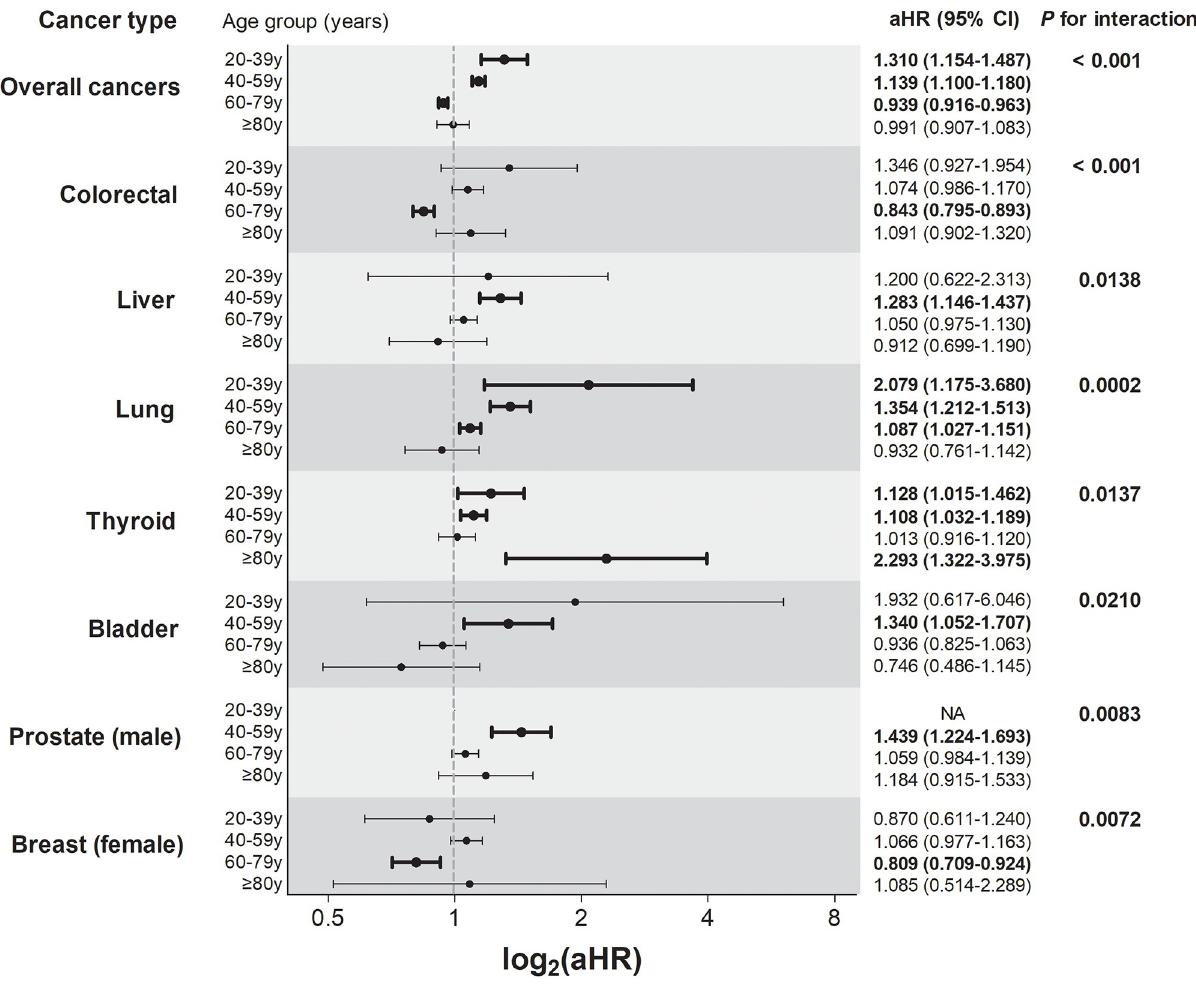
Fig 2. Effect of insomnia on the risk of some cancers stratified by age group. Results of all cancer types are presented in S2 Table. aHR, adjusted hazard ratio; CI, confidence interval. Thick lines and bold style indicate statistical significance ( p < 0.05).